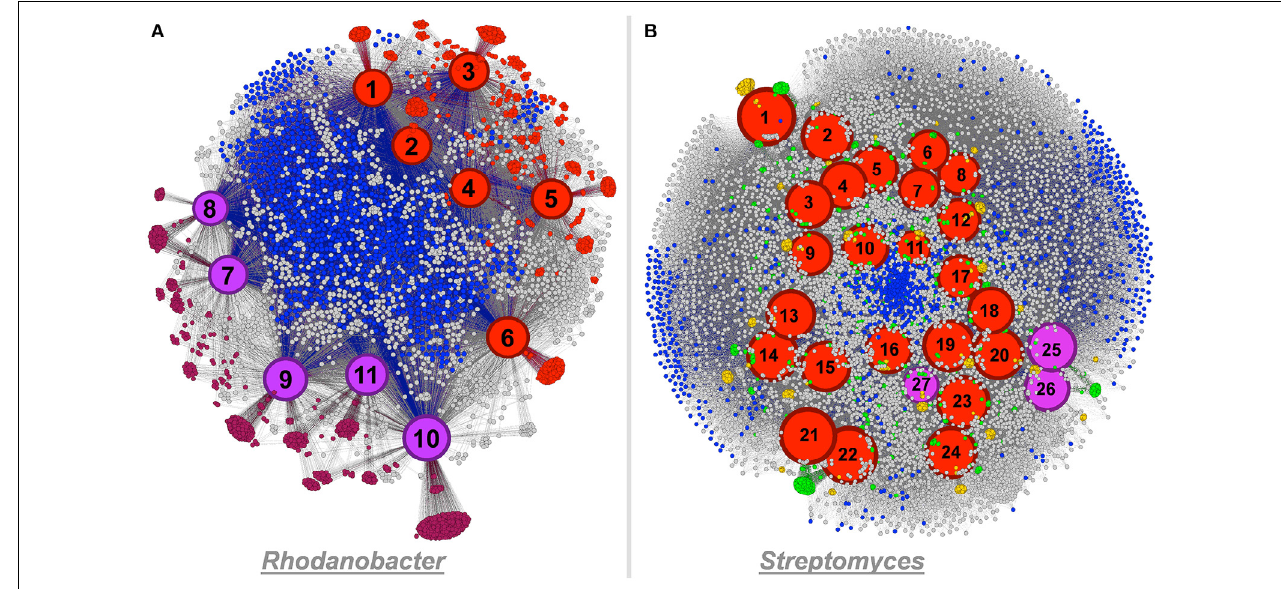
FIGURE 7 | Panel (A) functional network linking 11 Rhodanobacter genomes and their functionality (a total of 4,824 functions) using Gephi. Culture-derived genomes are represented by red nodes: 1, R. spathiphylli B39; 2, R. fulvus Jip2; 3, R. sp. 115; 4, R. denitrificans 116- 2; 5, R. thiooxydans LCS2; 6, R. sp. 2APBS1. Metagenomic-derived genomes are represented by purple nodes: 7, R. Metals-1; 8, R. Metals-2; 9, R. Mer-1A; 10, R. Mer-1B; 11, R. Mer-2. Genomic node sizes are positively correlated to the number of connected functions. For the functional nodes, red and purple nodes represent functions detected only in one or more culture-derived or metagenomic-derived genome, respectively. Finally, blue functional nodes are detected in the 11 genomes. Panel (B) functional network linking 27 Streptomyces genomes and their functionality (a total of 11,032 functions) using Gephi. Culture-derived genomes are represented by red nodes: 1, S.